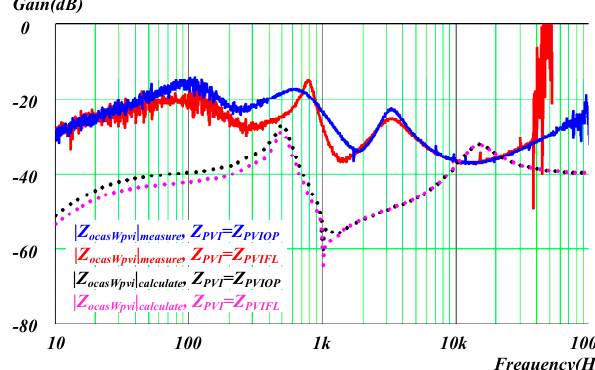
Figure 25. Measurement results and theoretical calculation results of overall output impedance.